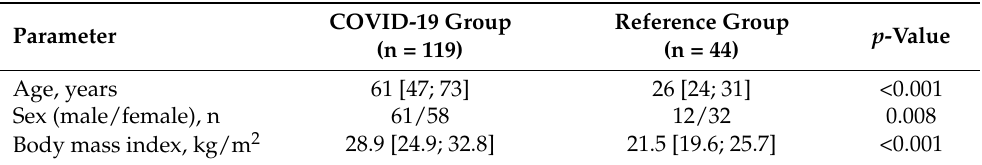
Table 1. General characteristics of the patients and individuals from the reference group. For a detailed description of the data format, please refer to Section 4.3.